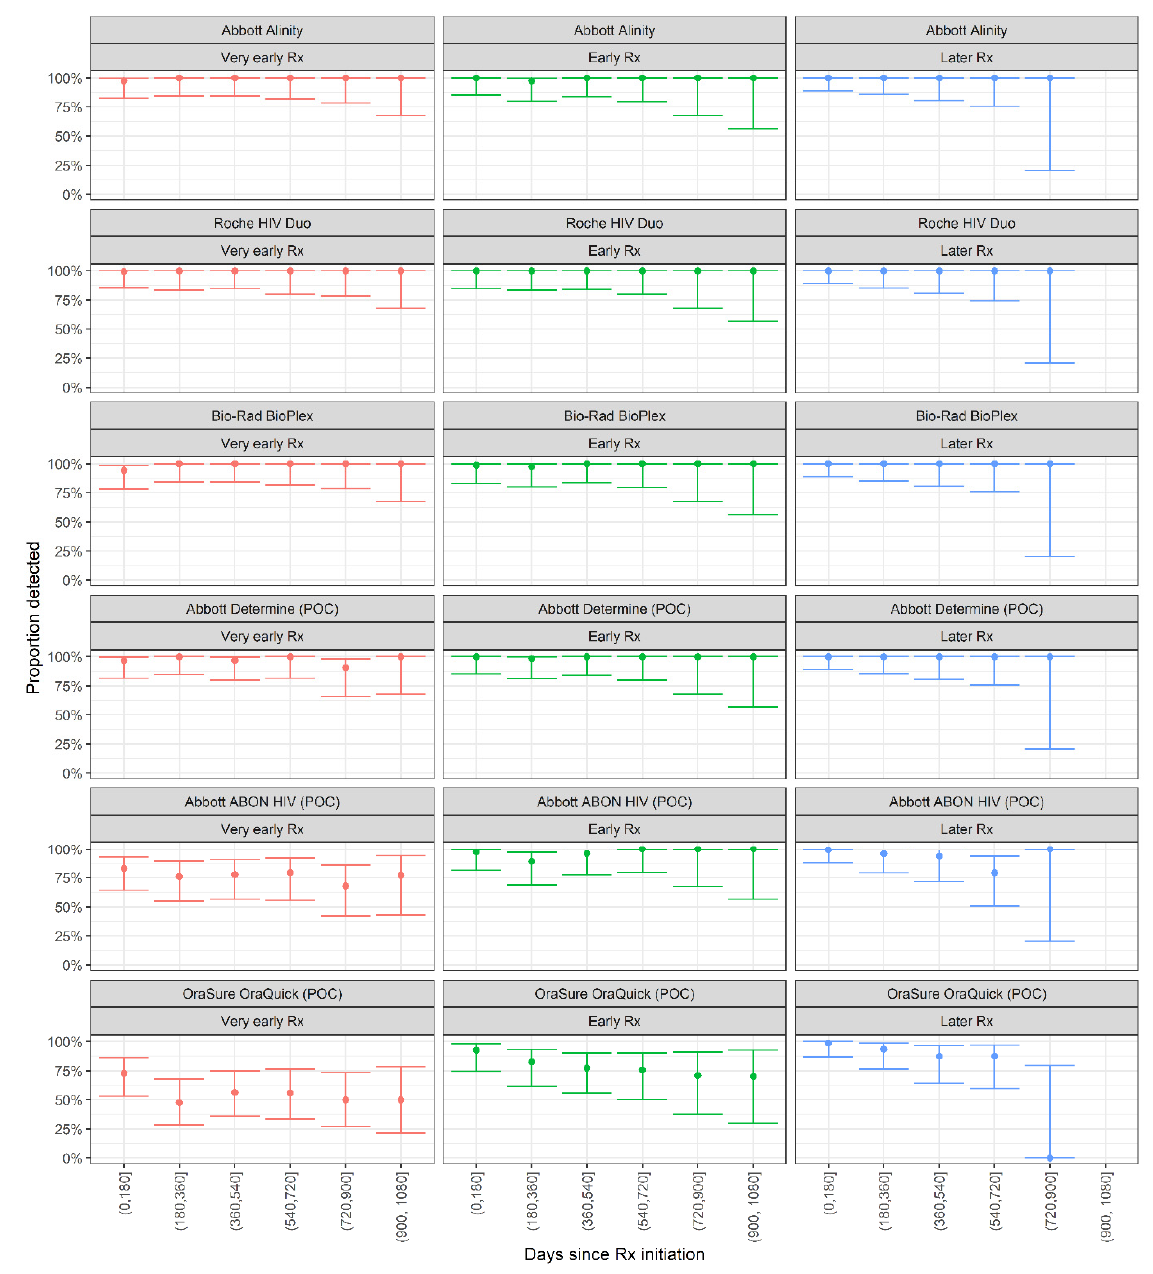
Figure 2. Proportion of donors returning reactive results on POC HIV antibody assays, stratified by 180-day intervals from infection to treatment (Rx) initiation. The points and whiskers indicate means and 95% confidence bounds.